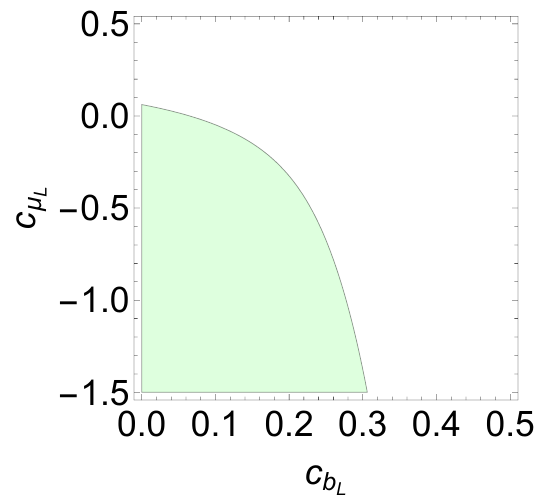
; c (cid:22) ) that accommodates (cid:1) g Z L L